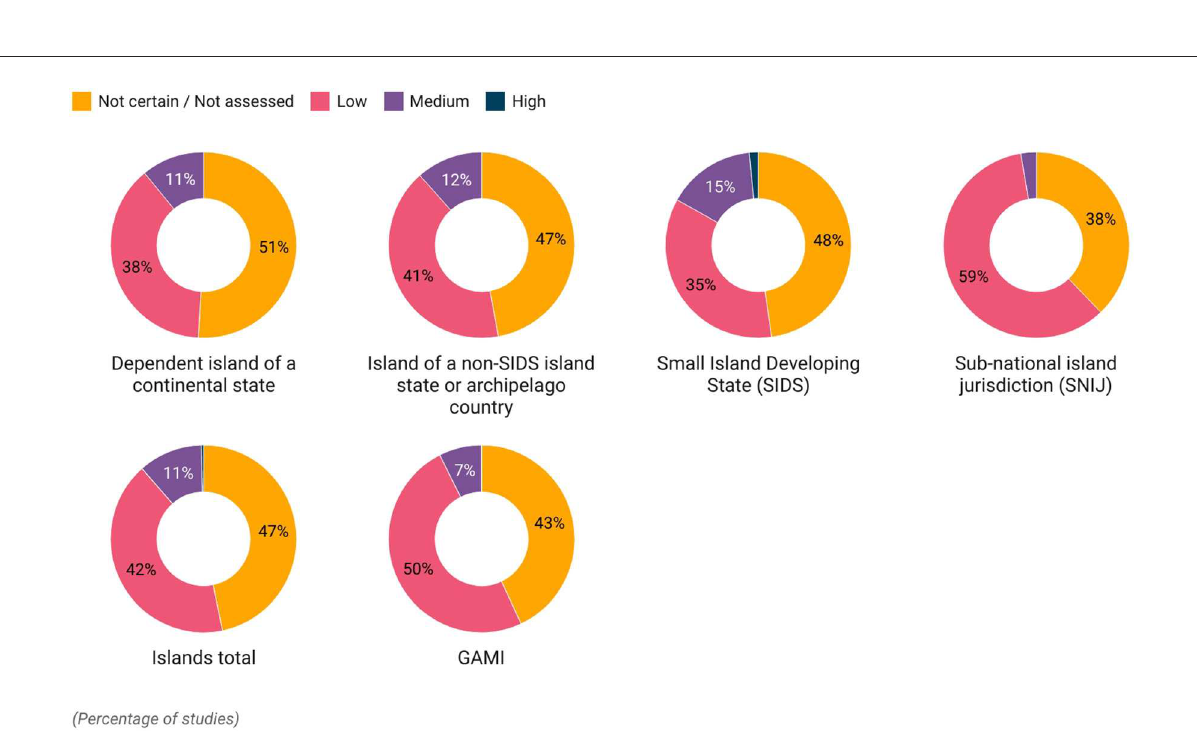
FIGURE10 Evidence of challenging limits to adaptation reported in island case studies compared to the whole GAMI